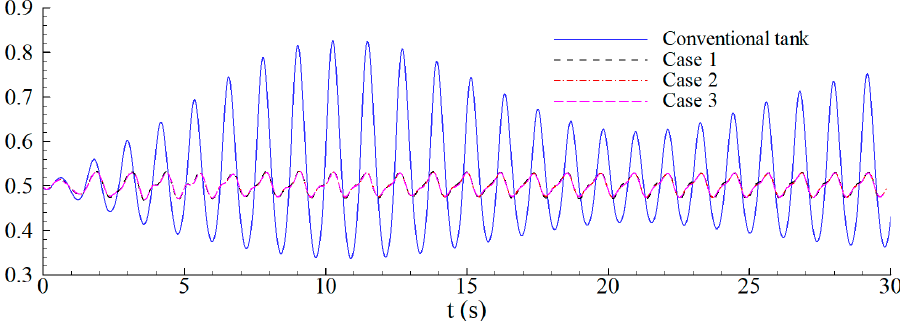
Figure 6. Comparison of the wave run-up on the left wall for various slot configurations.